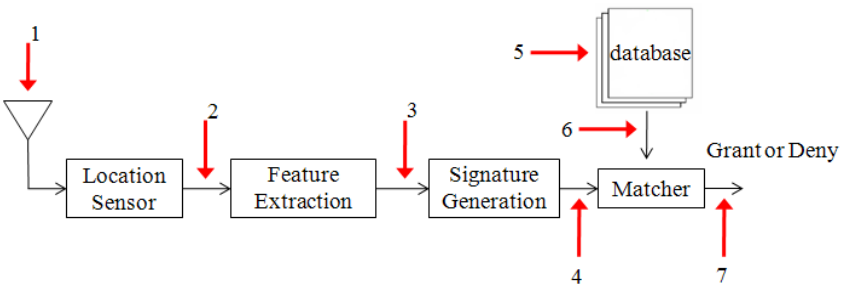
Figure 11. Threat model of generic